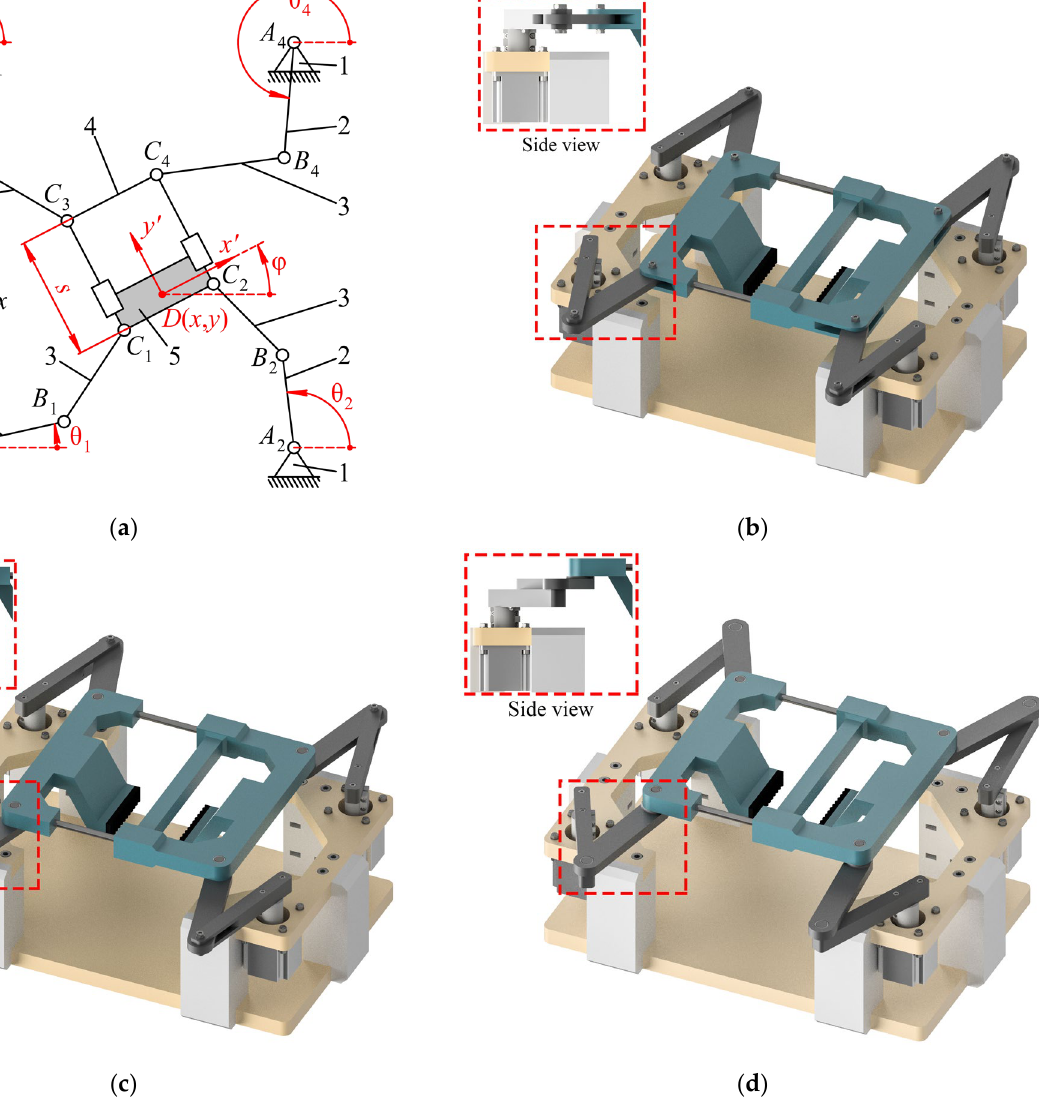
Figure 1. 4-DOF kinematically redundant planar parallel grasping manipulator: ( a ) structural scheme with kinematic notations; ( b )–( d ) CAD models of the manipulator with all links in a single layer ( b ), in two layers ( c ), and in three layers ( d